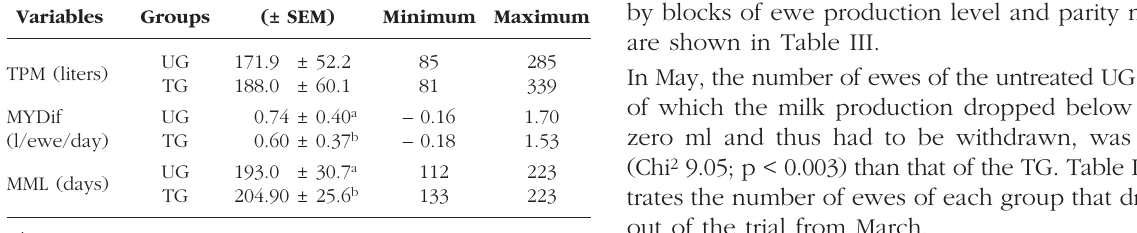
Table II. – Mean (± SEM) and ranges of total milk production (TMP), January-March difference in milk yield (MYDif) and machine-milking period length (MML) for levamisole treated (TG) and untreated (UG) groups.